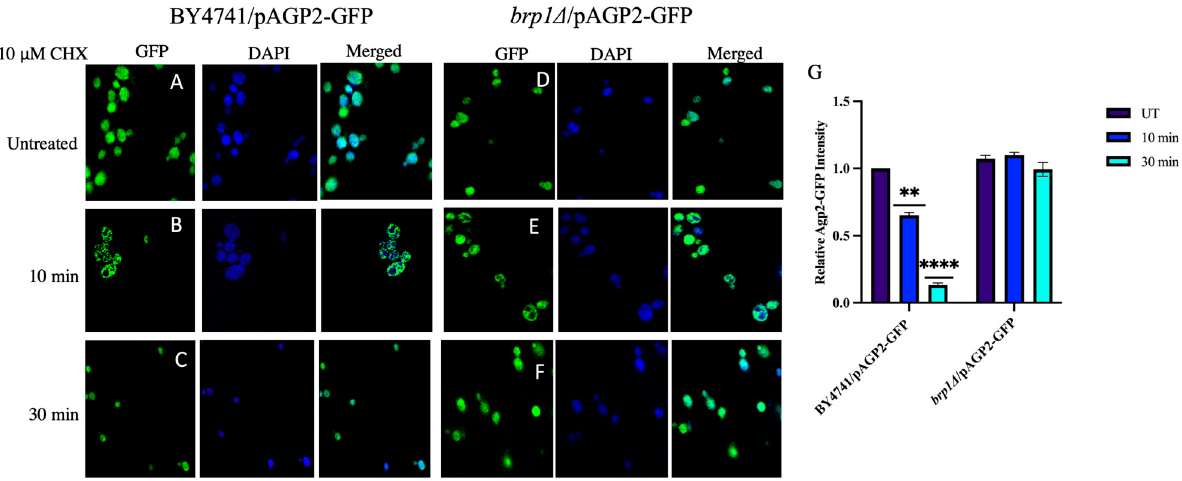
Figure 10. Confocal microscopy showing the distribution of Agp2-GFP in the WT and brp1 ∆ mutant in response to CHX. Briefly, exponentially growing cells were treated with CHX, washed, fixed, and imaged using confocal microscopy. ( A , B , D – F ) Cells were imaged at 100 × magnification and panel ( C ) at 60 × magnification. ( G ) Quantification of Agp2-GFP in the indicated strains following CHX treatment. Error bars indicate S.E. The data are representative of three biological replicates and analyzed by 2-way Anova Test. ** Is equivalent to p -value < 0.01, **** Is equivalent to p -value < 0.0001